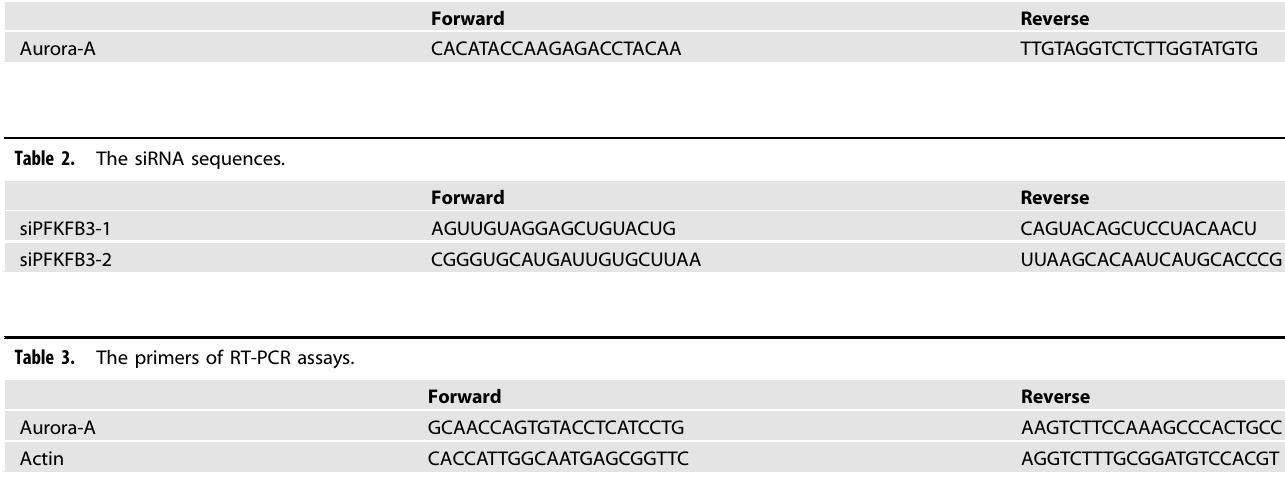
Table 2. The siRNA